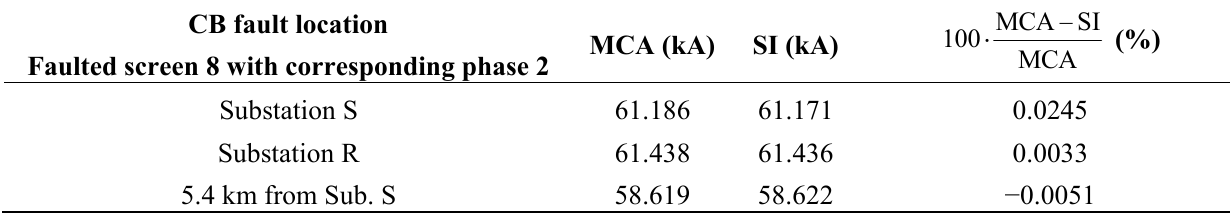
Table 3. Comparison between the MCA and sequence impedances (SI) approach for double circuit